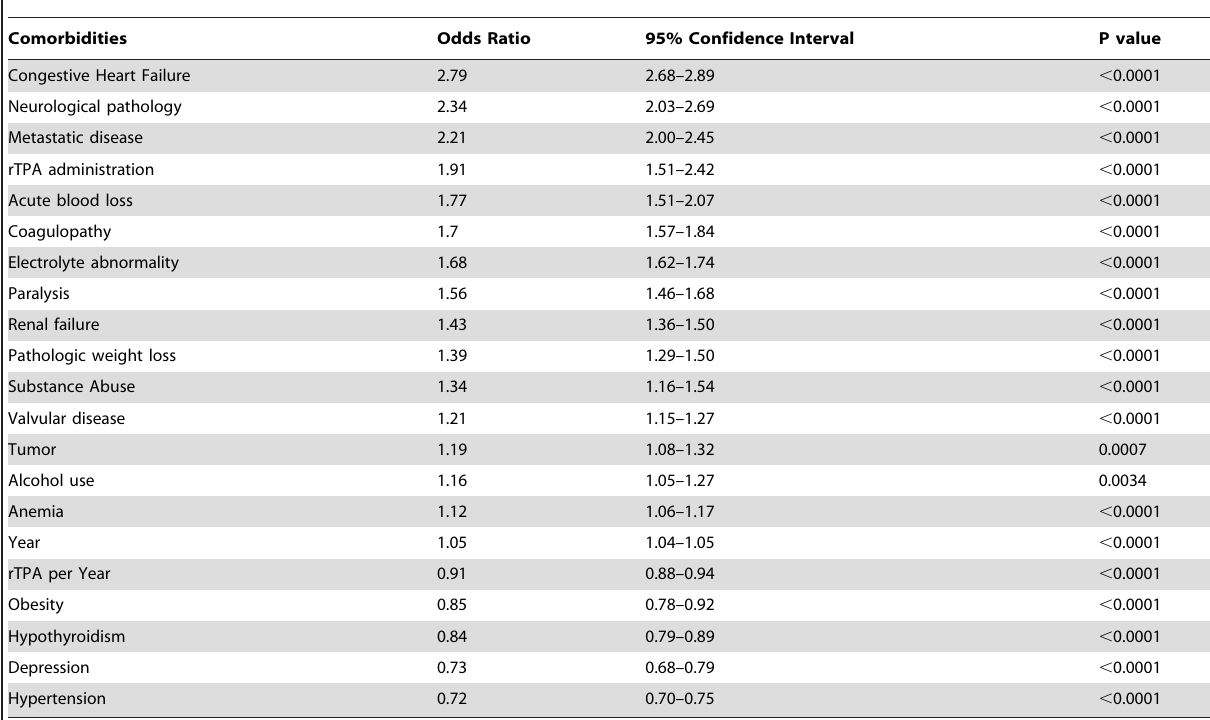
Table 4. Multivariate regression analysis predicting odds of having associated